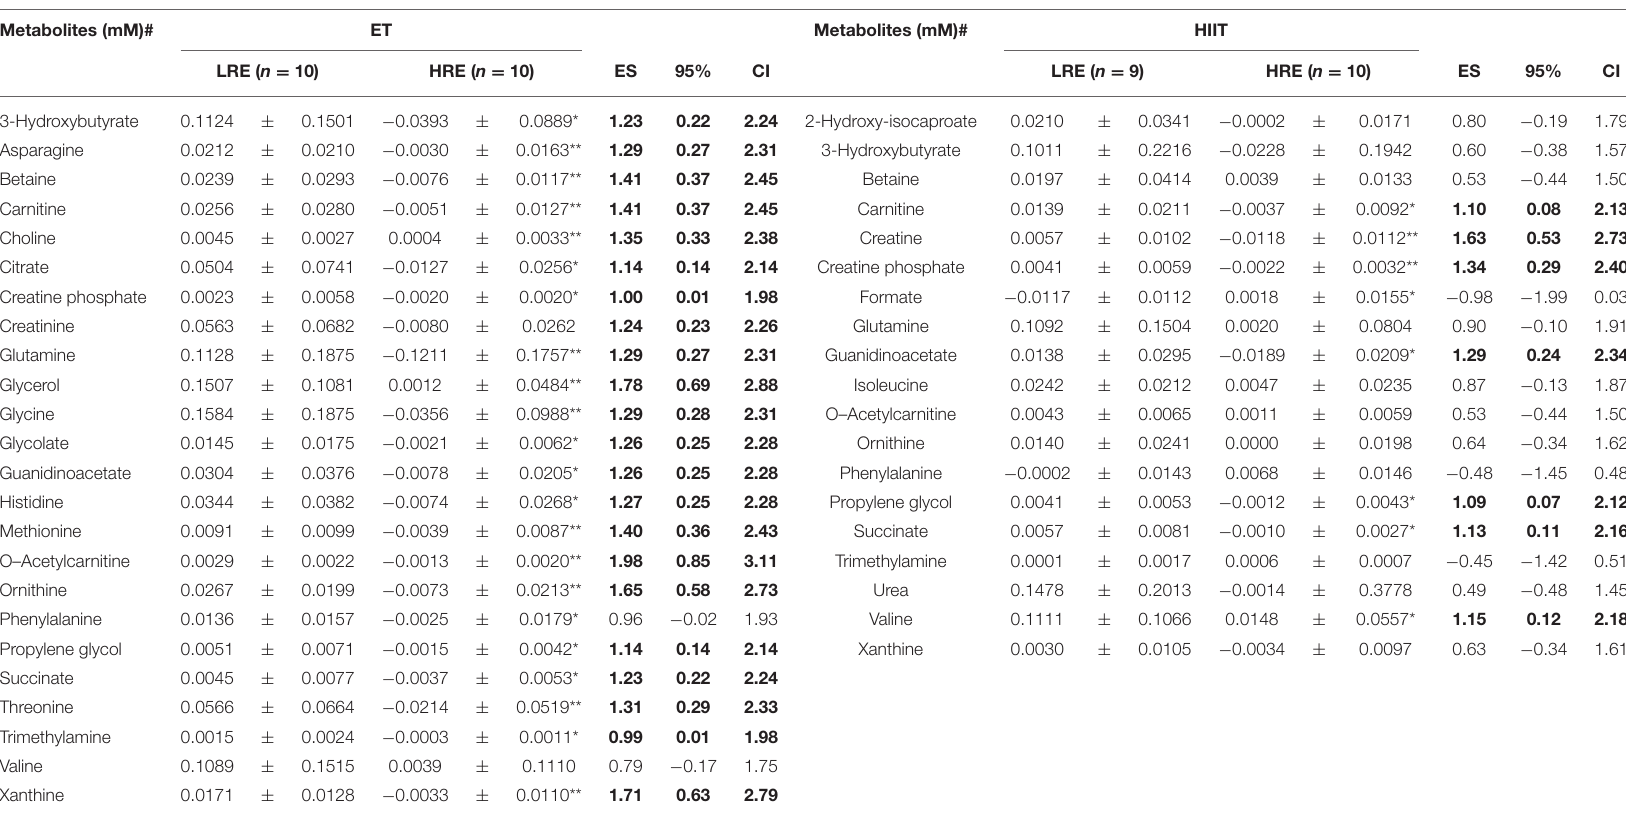
TABLE 3 | Comparison of the pretraining to post–training changes in serum metabolites’ concentration levels between low responders (LRE) and high responders (HRE) to the ET and HIIT programs in the TIMES